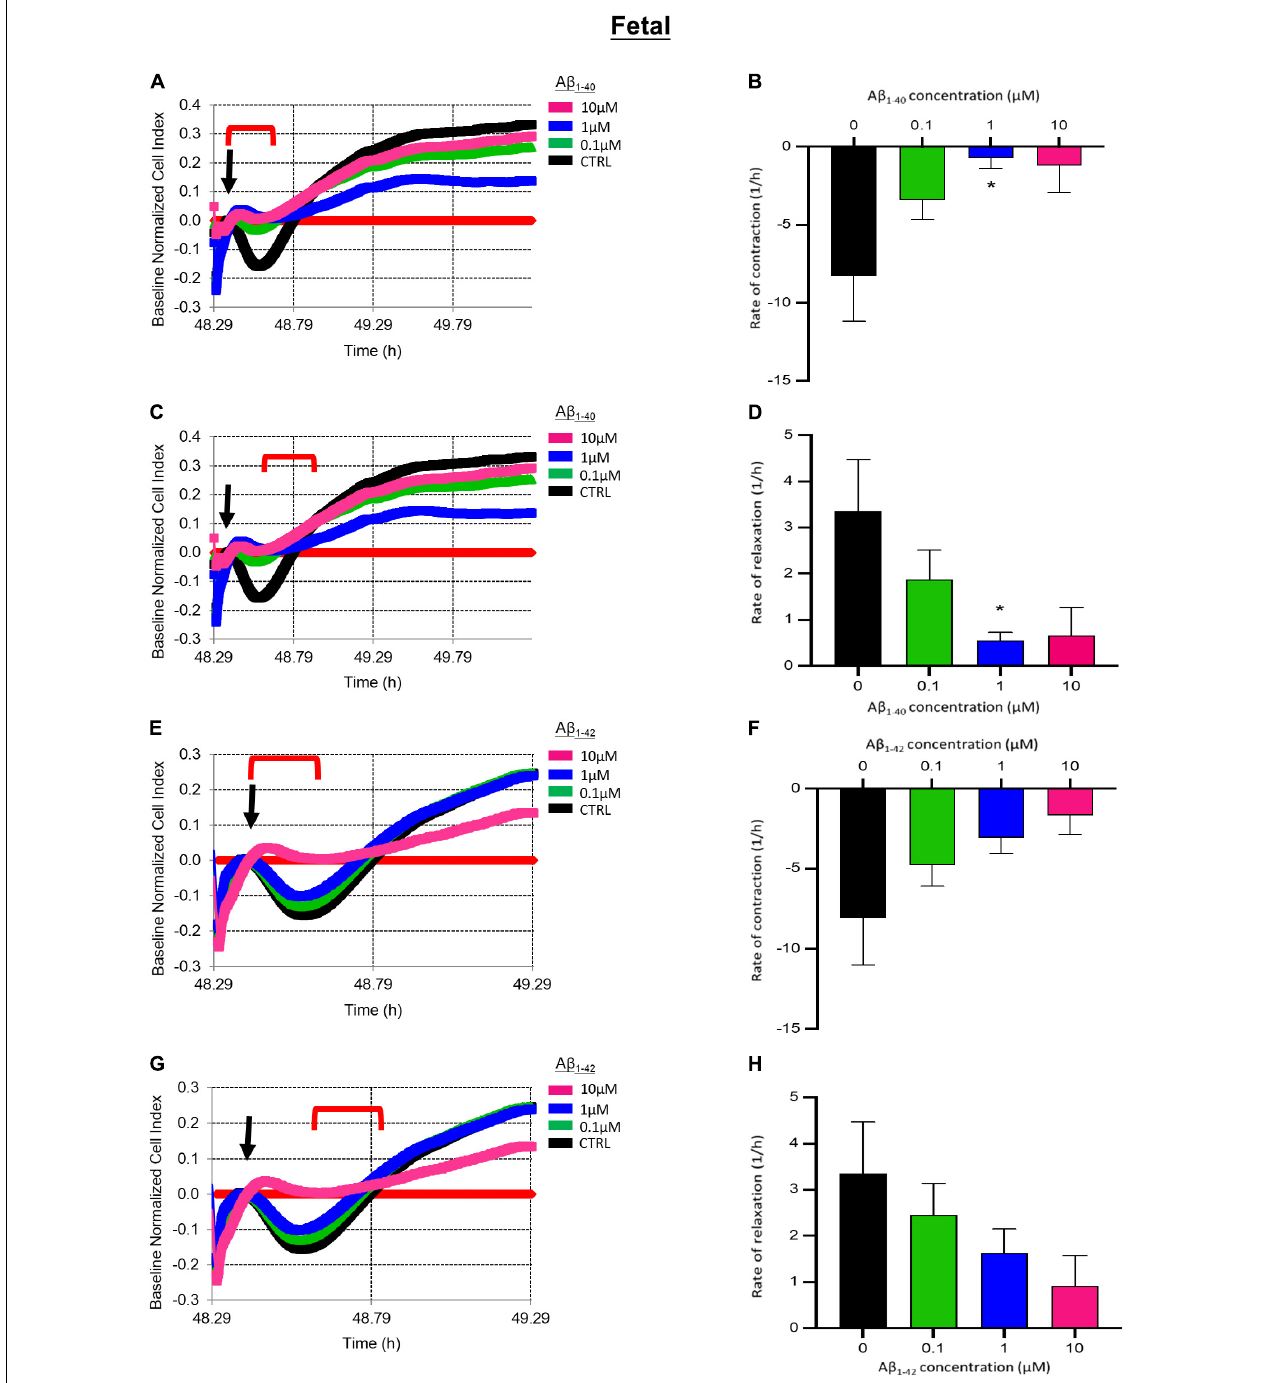
FIGURE 7 | (A) Representative electrical impedance measurements of the contractile response of fetal human brain vascular pericytes (fHBVP) to EDN1 (100 nM) after 24 h incubation with A β 1 − 40 ( n = 1). (B) There was a significant difference between the rate of contraction of untreated cells and those exposed to 1 µ m ( p = 0.0249) A β 1 − 40 ( n = 9). (C) Representative electrical impedance measurements of the relaxation response of fHBVP following contraction ( n = 1). (D) There was also a significant difference between the rate of subsequent relaxation in untreated of cells and those exposed to 1 µ m ( p = 0.0409) A β 1 − 40 ( n = 9). (E) Representative electrical impedance measurements of the contractile response of these fHBVP to EDN1 (100 nM) after 24 h treatment with A β 1 − 42 ( n = 1). (F) The differences in the rate of contraction between EDN1-treated cells following pre-exposure to A β 1 − 42 were not statistically significant ( n = 9). (G) Representative electrical impedance measurements of the relaxation response of fHBVP following contraction ( n = 1). (H) There was also no significant difference in rate of subsequent relaxation ( n = 9). The timeframe referred to in each graph is indicated by the red bracket. Arrows indicate the timepoint of EDN1 addition. The bars represent the mean values and